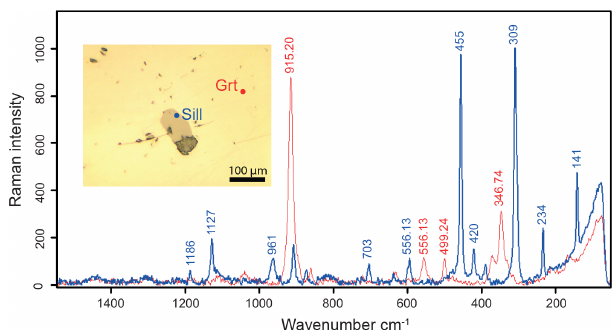
Figure 8. Raman spectra for a sillimanite inclusion from a garnet core in the Nordmannvik migmatite (sample